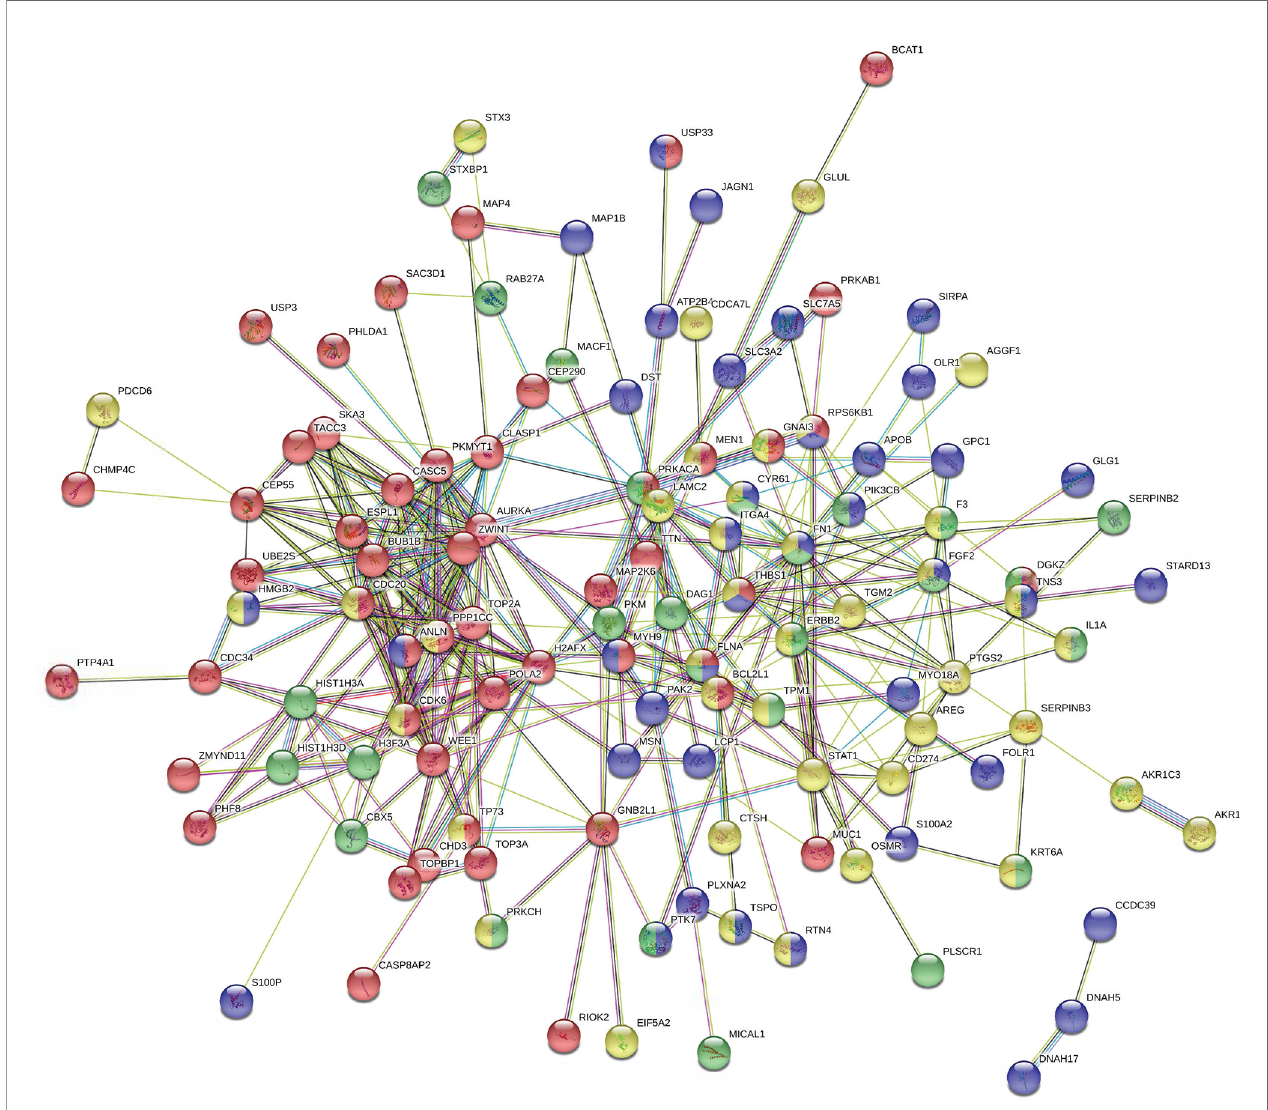
FIGURE 5 | STRING protein-protein interaction network for the 138 proteins involved in cell proliferation, cell cycle, and cell migration. Network of interactions among 138 regulated proteins involved in cellular processes. Network nodes represent the proteins. A protein/node may be fi lled with up to four different colors. Yellow represents proteins involved in cell proliferation, red represents proteins involved in cell cycle, green represents proteins involved in wound healing, and blue represents proteins involved in cell motility. The minimum required interaction score was medium con fi dence (0.400). The structure previews of proteins are displayed inside the nodes. All the disconnected nodes in the network were hidden. The details of this fi gure are presented in Table S5